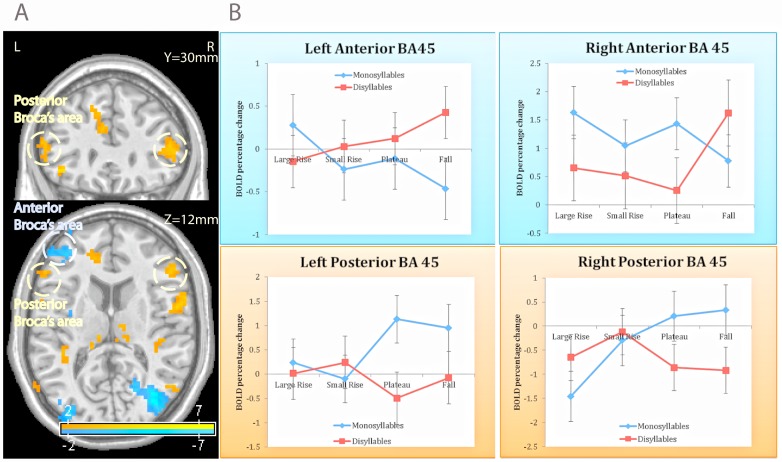
The effect of the syllable hierarchy on Broca's area.The syllable structure manipulation activated posterior Broca's area, but deactivated its anterior region (A). An inspection of the BOLD signal (B) showed that these changes were monotonically linked to the well-formedness of the monosyllables, but not their disyllabic counterparts. Responses to monosyllables are plotted in blue; disyllables are indicated in red.